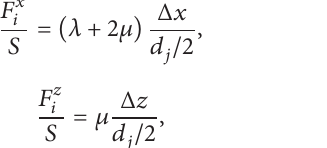
Figure 6: Calculation of band structure with lumped mass method.